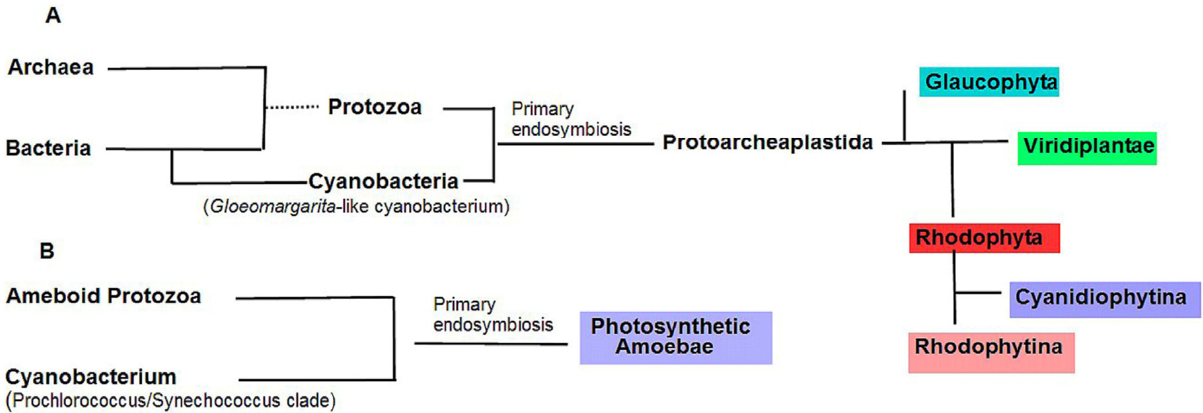
Figure 1. Scheme of primary endosymbioses in the origin of plastids. ( A ) The monophyletic origin of three phyla of Archaeplastida (Glaucophyta, Viridiplantae, and Rhodophyta). The length of the segments connecting the groups in sequence (from left to right) corresponds to the timing of their appearance. The Rhodophyta branch consists of the early isolated subphyla of microalgae Cyanidiophytina and subphyla Rhodophytina [7] containing some micro- and all macrophyte algae. ( B ) A later independent endosymbiosis that led to the appearance of photosynthetic amoebae.